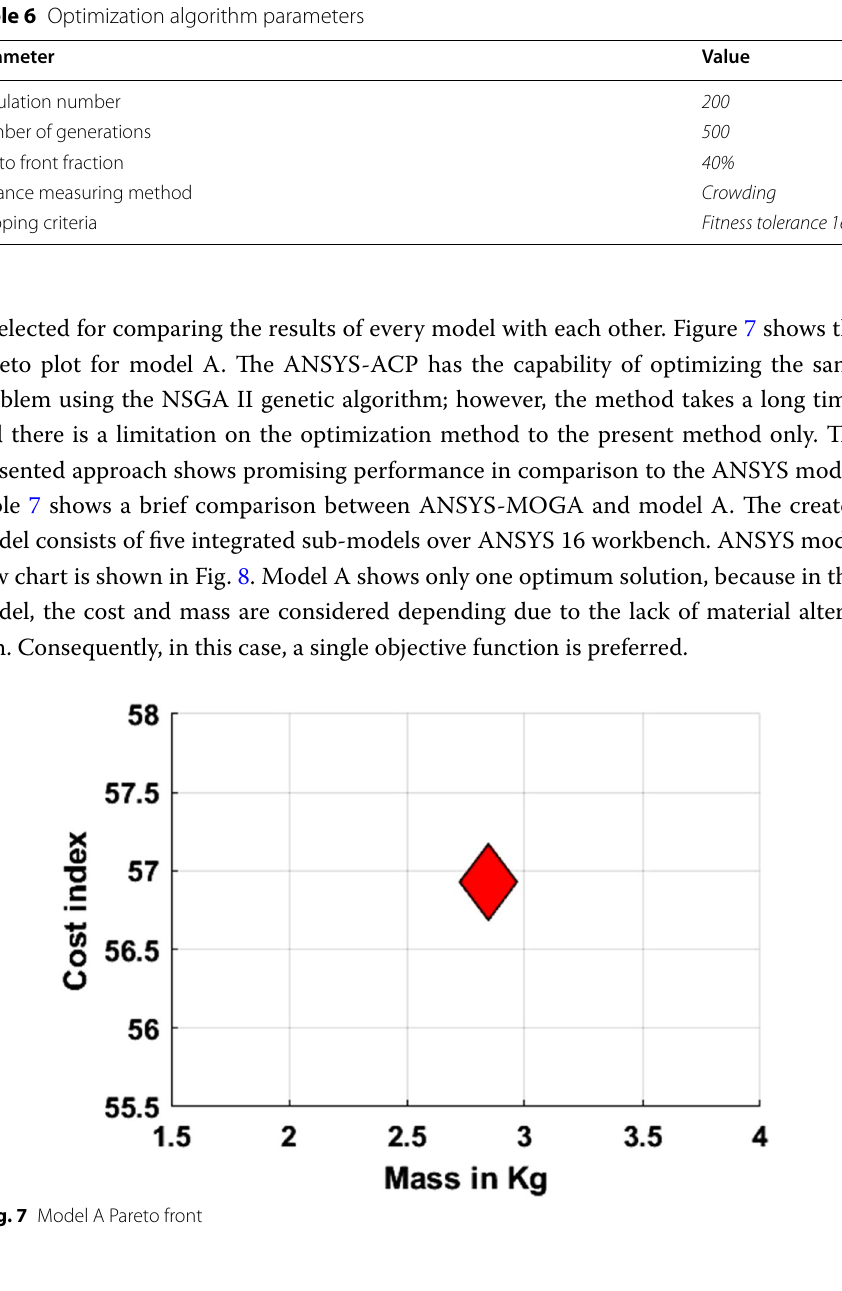
Table 7 ANSYS and approach A optimization comparison Item